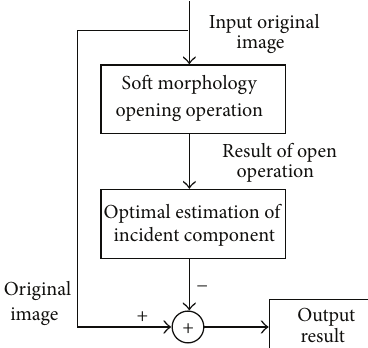
Figure 6: Background suppression flowchart based on soft mor- phology and Retinex